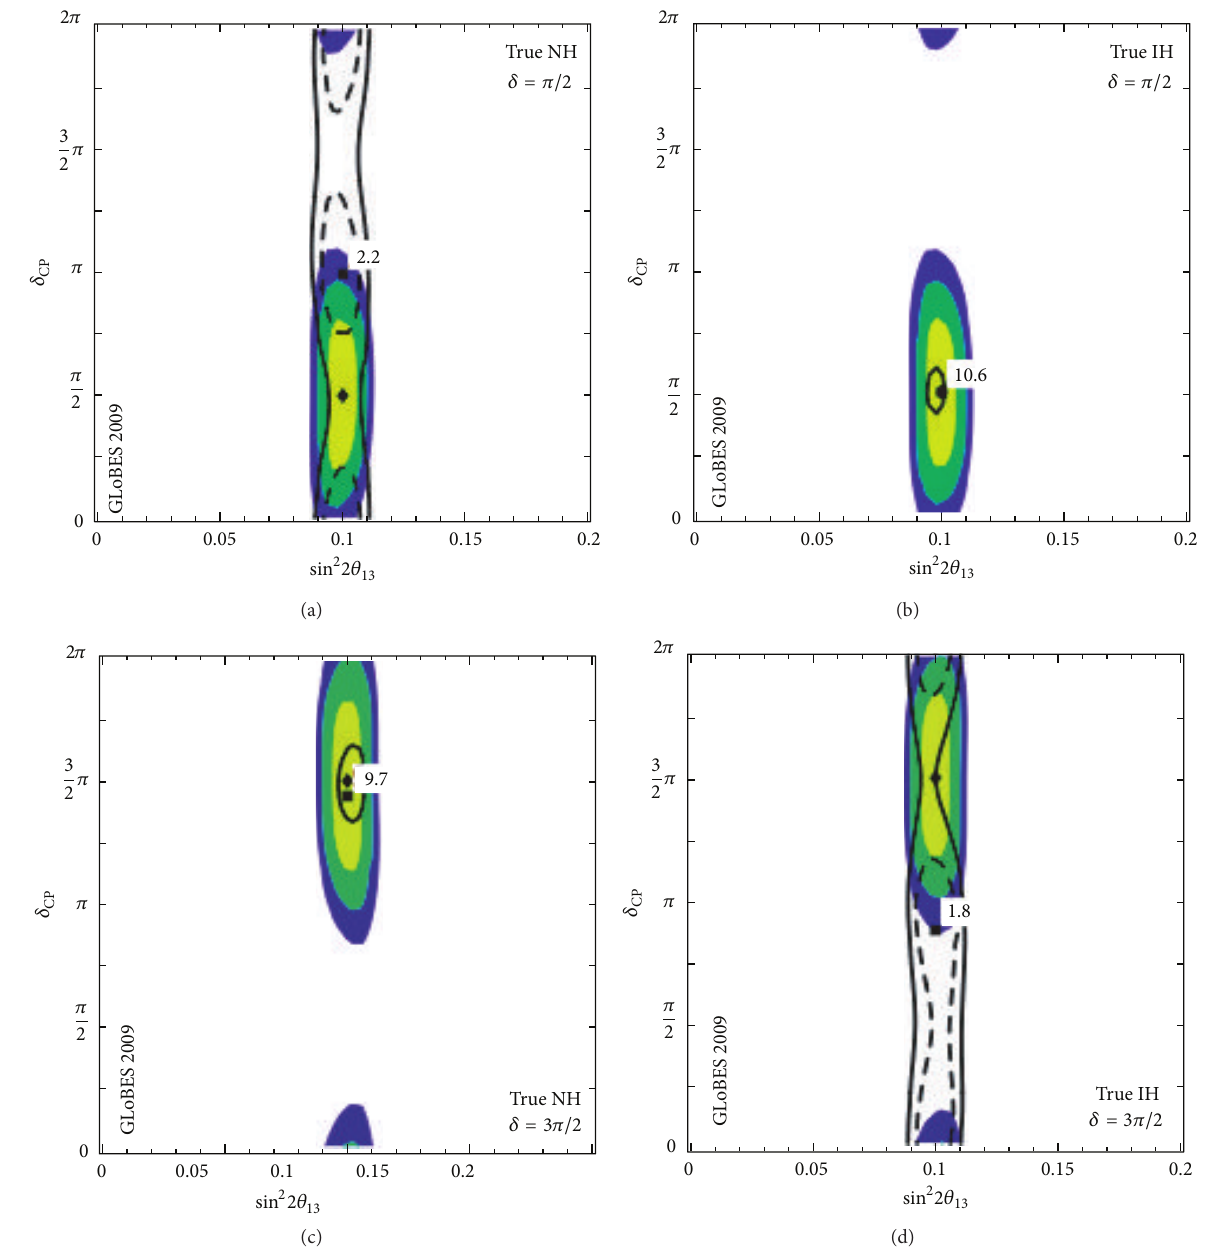
Figure 4: Fits in the 𝜃 13 − 𝛿 plane for sin 2 2𝜃 13 = 0.1 , 𝜃 23 = 𝜋/4 , and 𝛿 = 𝜋/2 (upper row) and 𝛿 = 3𝜋/2 (lower row) and a true NH (left panels) and IH (right panels), assuming the final exposure from T2K, NOvA, and DayaBay according to Table 2. The contours refer to 1𝜎 , 2𝜎 , and 3𝜎 (2 dof). The fit contours for the right fit hierarchy are shaded (colored), and the ones for the wrong hierarchy fit are shown as curves. The best-fit values are marked by diamonds and boxes for the right and wrong hierarchy, respectively, where the minimum 𝜒 2 for the wrong hierarchy is explicitly shown. Figures are based on the results of